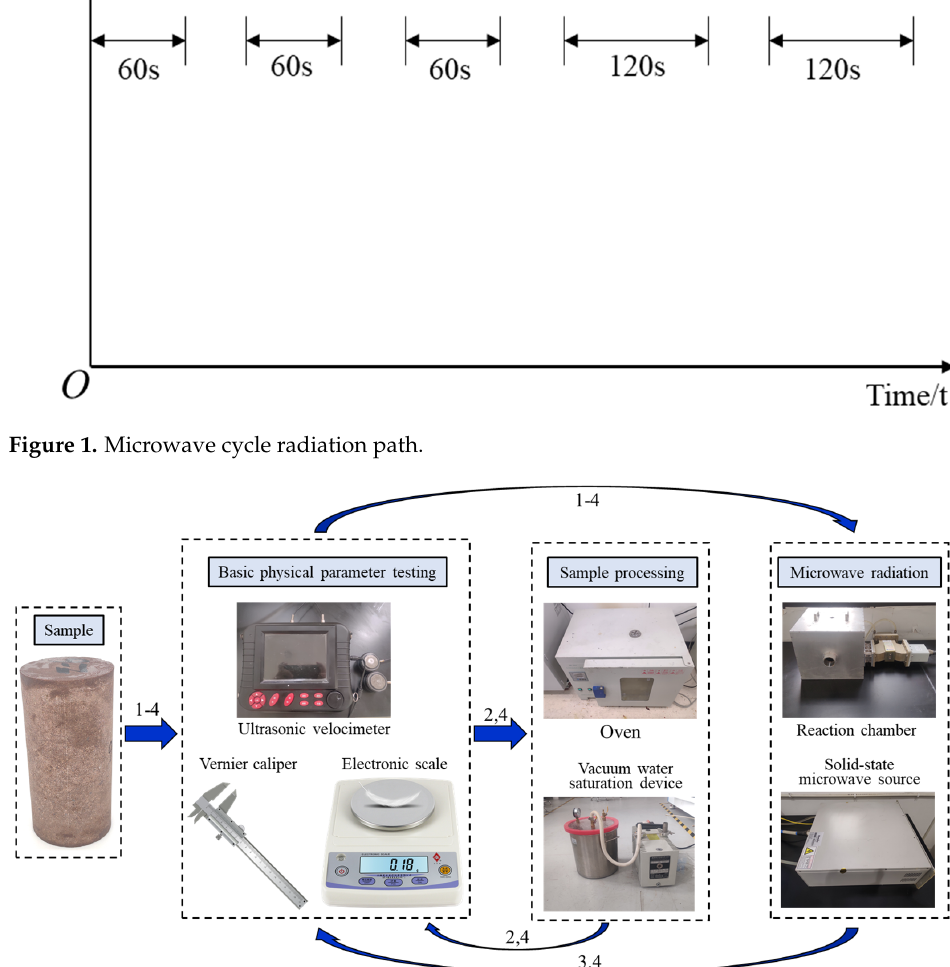
Figure 2. Experiment process and equipment.